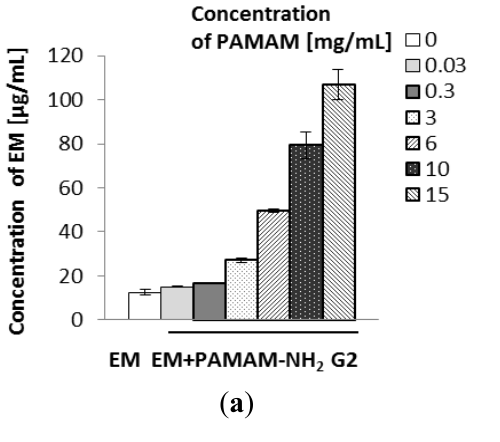
Figure 3. Solubility of erythromycin in the presence of various concentrations of generation 2 ( a ), PAMAM-NH PAMAM-NH 2 2 ( c ), PAMAM-OH generation 3 ( d